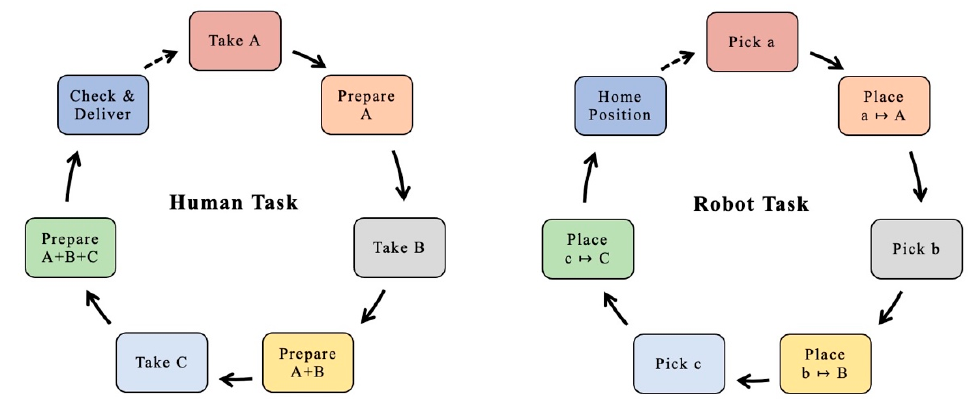
Figure 3. Task phases.